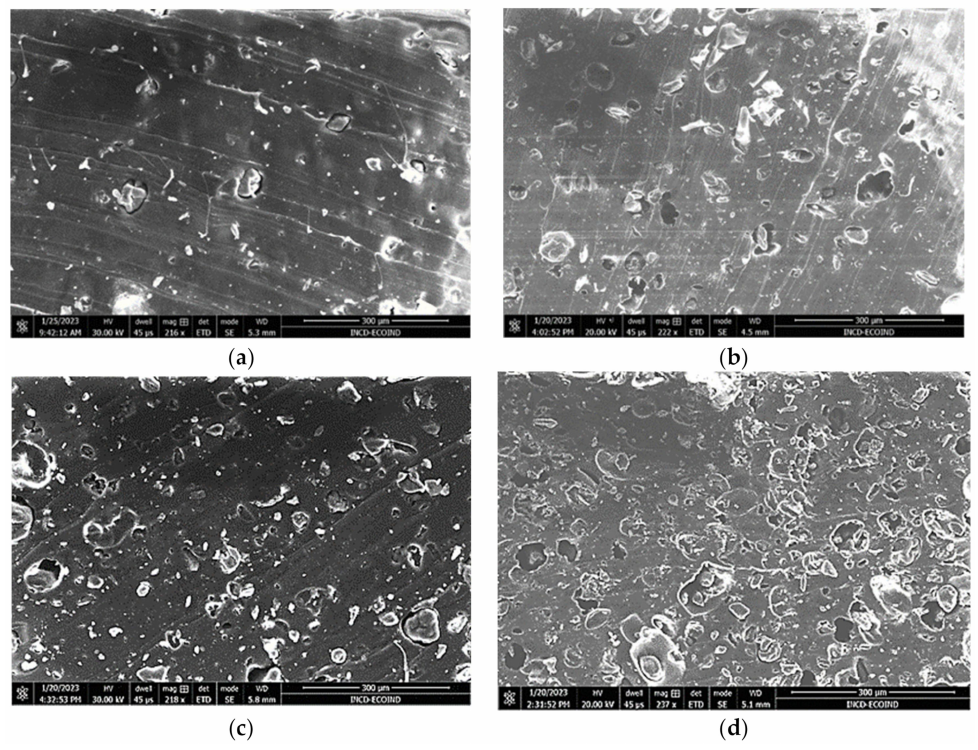
Figure 5. SEM images of polymer MSBS composites with 5% ( a ), 10% ( b ), 20% ( c ), and 30% ( d ) Arthrospira platensis biomass.